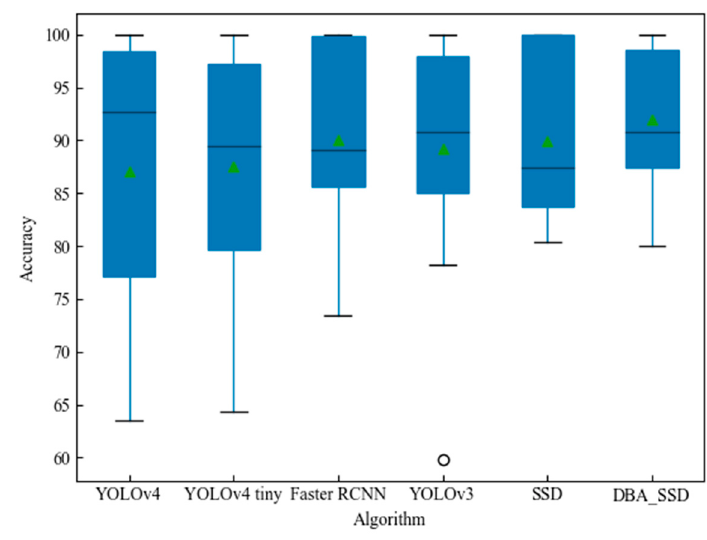
Figure 15. Box plot of AP statistics under target detection algorithm.